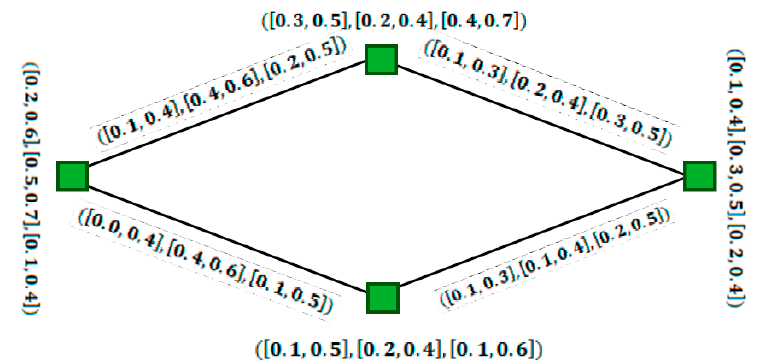
Figure 21. Interval-valued neutrosophic graph with undefined intervals.